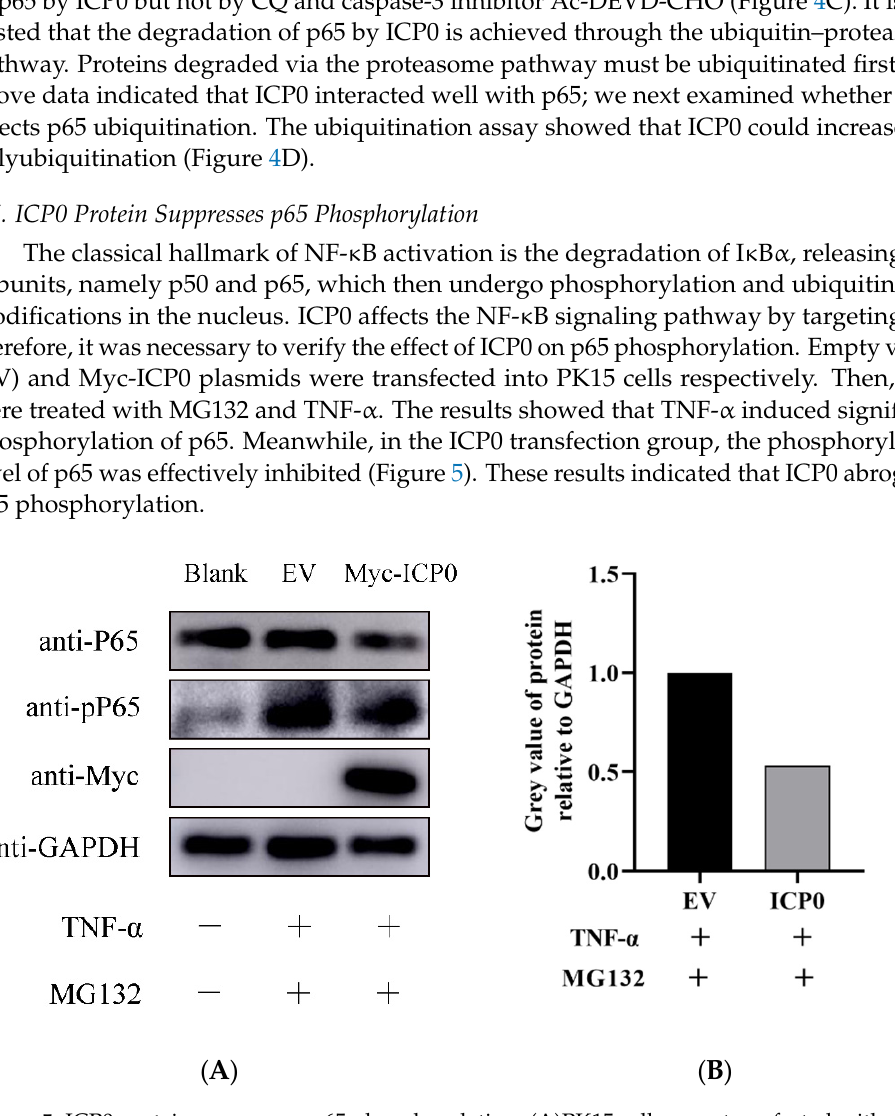
Figure 5. ICP0 protein suppresses p65 phosphorylation. ( A )PK15 cells were transfected with empty vector (EV) (1.0 µ g) or Myc-ICP0 (1.0 µ g) plasmids for 24 h and then stimulated with TNF- α (50 µ g/mL) for 12 h. Cells were treated with 7.5 µ M MG132 for another 12 h before collection. p65, phosphorylated p65 (pP65) and ICP0 protein (Myc) expression were detected by immune blot- ting. GAPDH served as loading control. ( B ) The grey value of p65 phosphorylation relative to GAPDH was